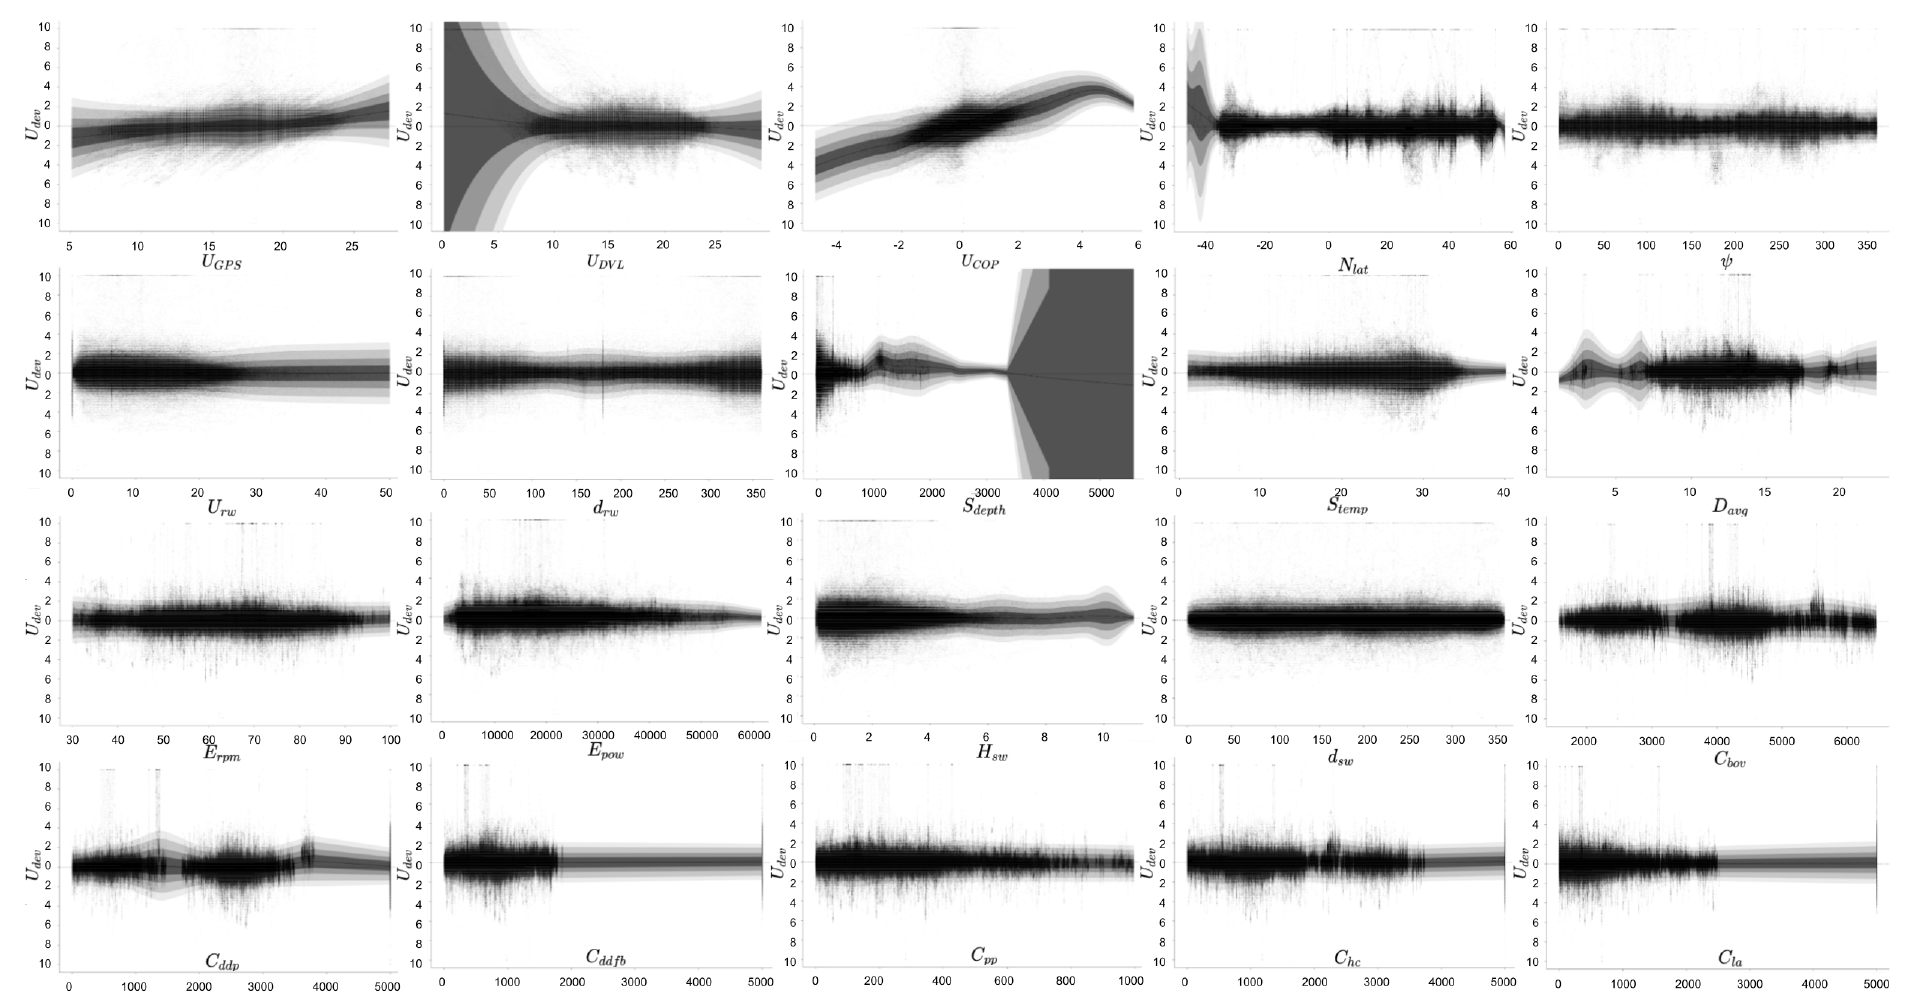
Figure 21. GAMLSS multiplot of U dev versus the rest of the continuous features of the main